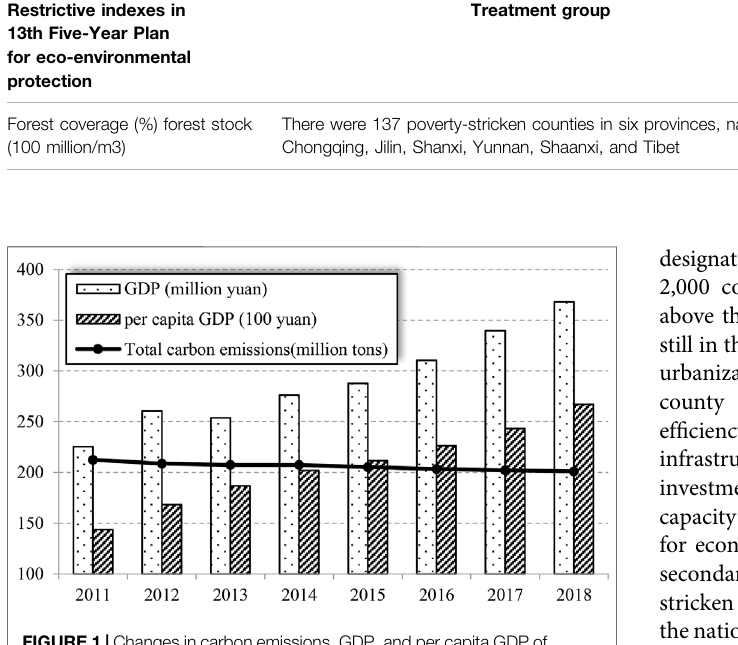
Table 2 from 2011 to 2018. The average annual GDP of 393 state-designated poverty-stricken counties was 7.201 billion, and the average per capita GDP was 20,700 yuan.